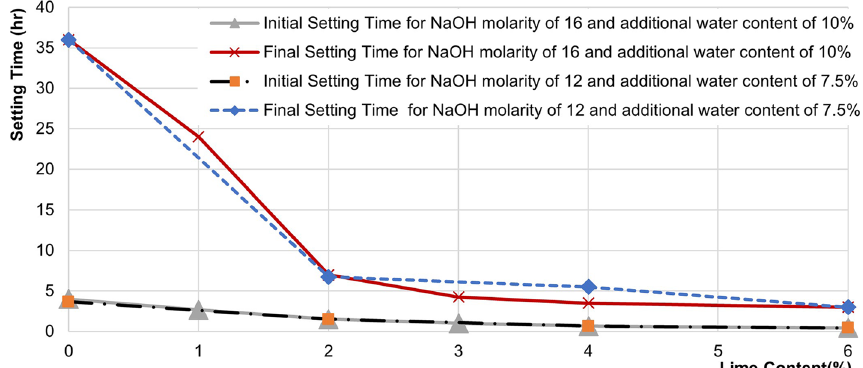
Fig. 1 The relation between initial and final setting times of fresh concrete and lime